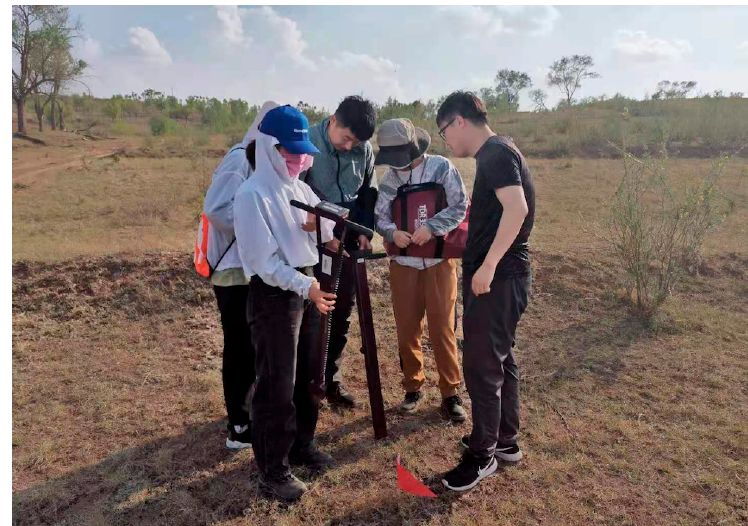
Figure 2. A sample point in the field survey.